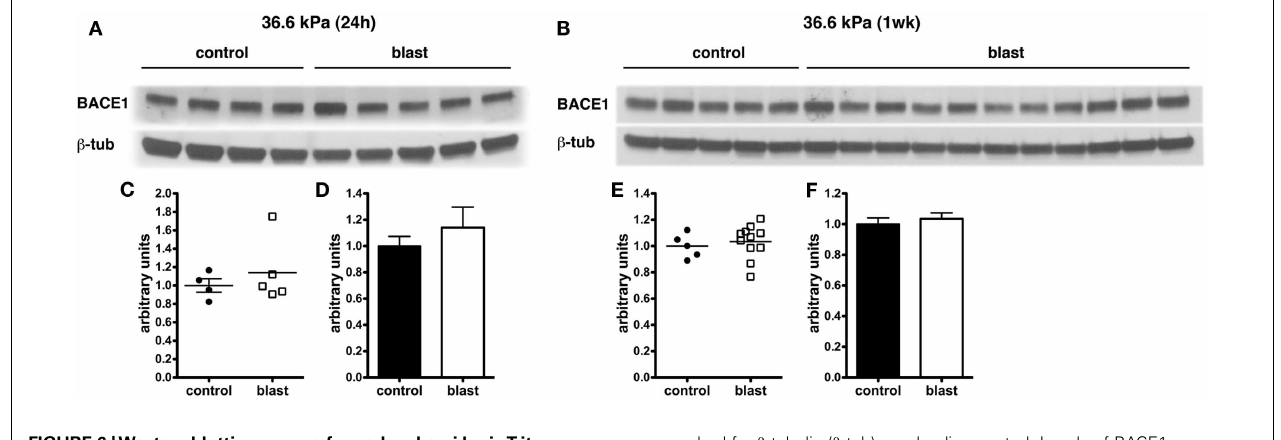
reprobed for β -tubulin ( β -tub) as a loading control. Levels of BACE1 are expressed as the ratio of BACE1 to β -tubulin ( ± SEM) for the experiments in (A) in (C,D) and for (B) in (E,F) . Note the lack of change in BACE1 levels in rats exposed to a 36.6kPa blast at either 24h or 1week.